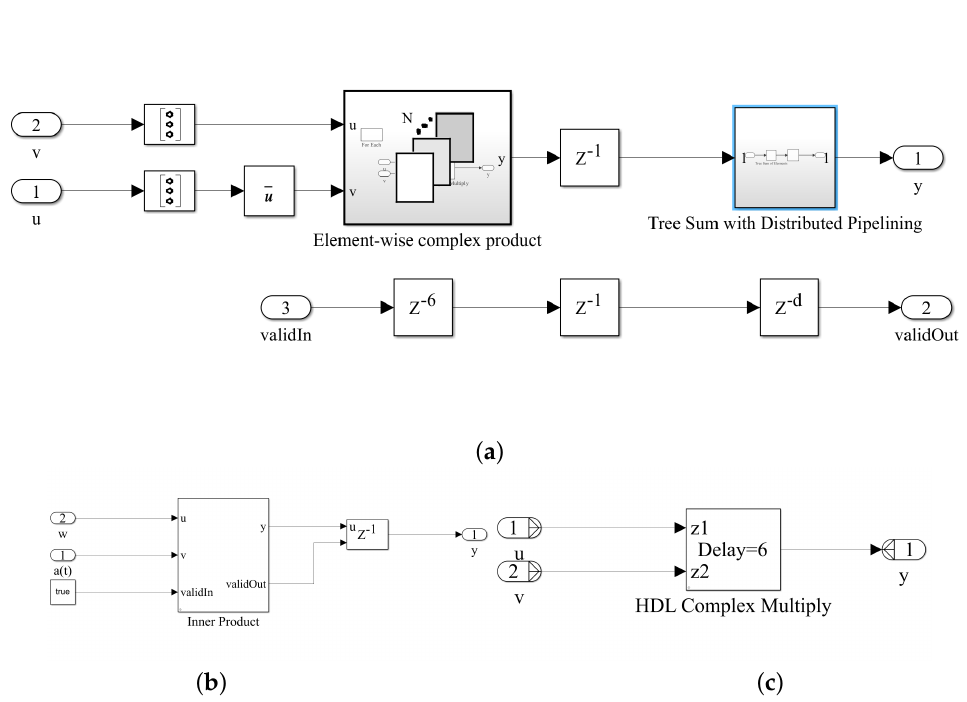
Figure 9. ( a ) A hardware demonstration for the inner products in the QS-SVM-based beamformer